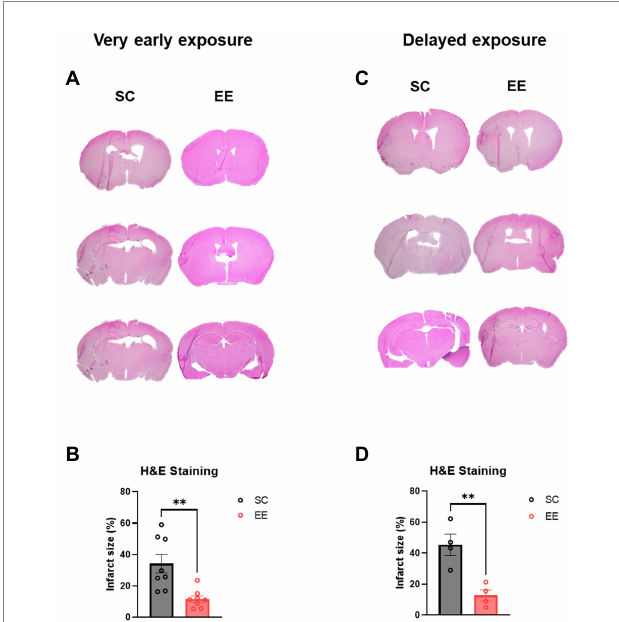
FIGURE 3 Histological assessments of the very early and delayed EE exposure groups. (A,B) Representative H&E images (A) and quantification of infarcted volume (B) after very early exposure to EE ( n = 8 per group). (C,D) Representative H&E images (C) and quantification of infarcted volume (D) after delayed exposure to EE ( n = 4 per group). H and E,